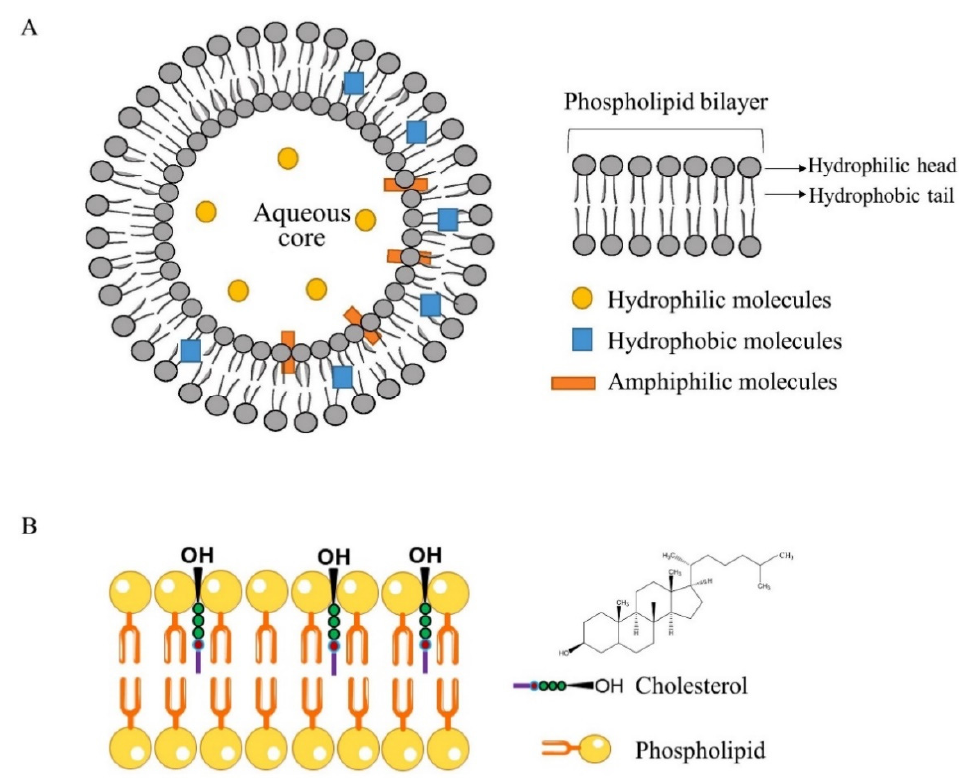
Figure 1. ( A ) The general structure of liposomes. Reprinted with permission from [2]. Copyright (2021), Elsevier. ( B ) The location of cholesterol in the phospholipid bilayer membrane. Reprinted with permission from [24]. Copyright (2019), Elsevier.